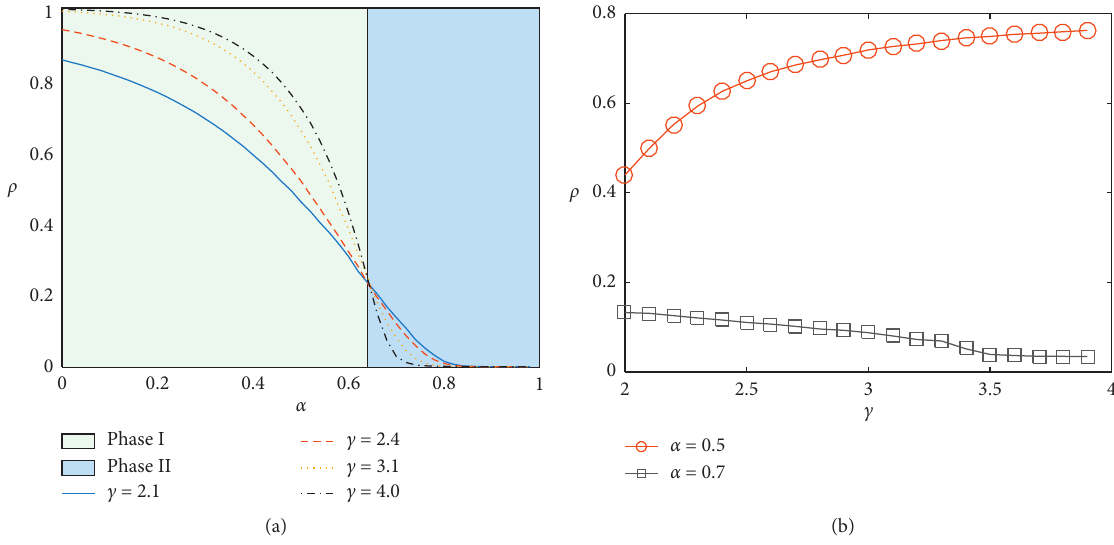
Figure 7: Effects of self-awareness and network structure on the spreading dynamics. (a) Plots of ρ vs. α when c � 2 . 1 (blue line), c � 2 . 4 (red line segment), c � 3 . 1 (yellow dots), and c � 4 . 0 (black dotted line), respectively. The two regions marked by phase I (filled by gray) and phase II (filled by sky blue) are separated by the critical value α ∗ ≈ 0 . 64. (b) The value of ρ as a function of c when α � 0 . 5 (red circles) and α � 0 . 7 (black squares), respectively. The basic transmission rate is set at β � 0 . 2, and the other parameters are the same as those in Figure